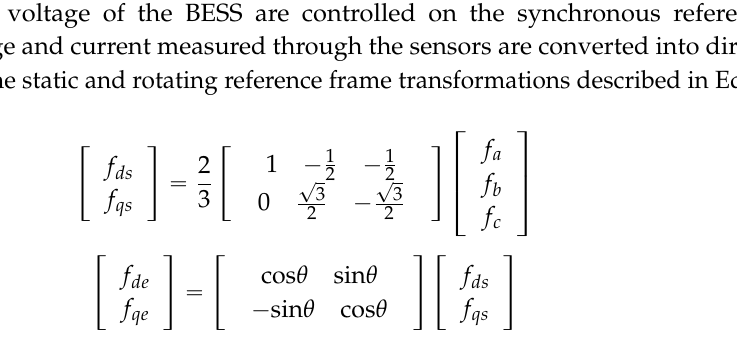
Figure 1. System configuration of a battery energy storage system (BESS) connected to a load generator.